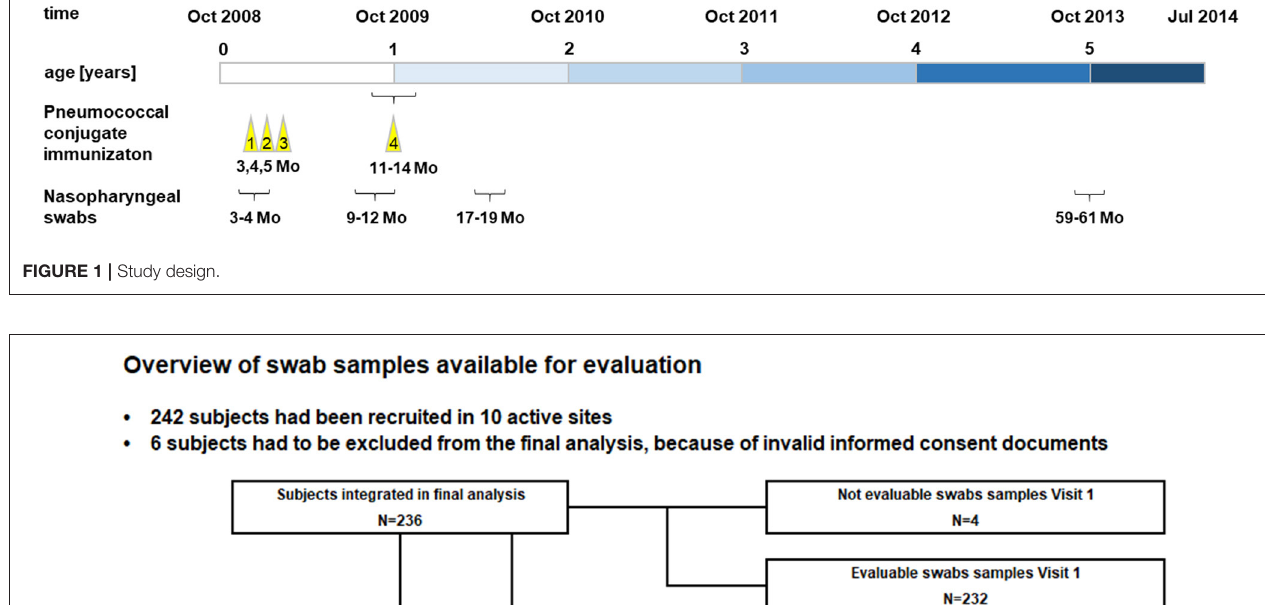
Absolute and relative frequencies of total pneumococcal carriage were calculated based on all evaluable subjects, including the 95%CI. Additionally, we stratified by vaccine-serotype pneumococci to estimate any potential impact of PCVs on carriage. The analyses were performed separately for the different time points. Secondary target variables were